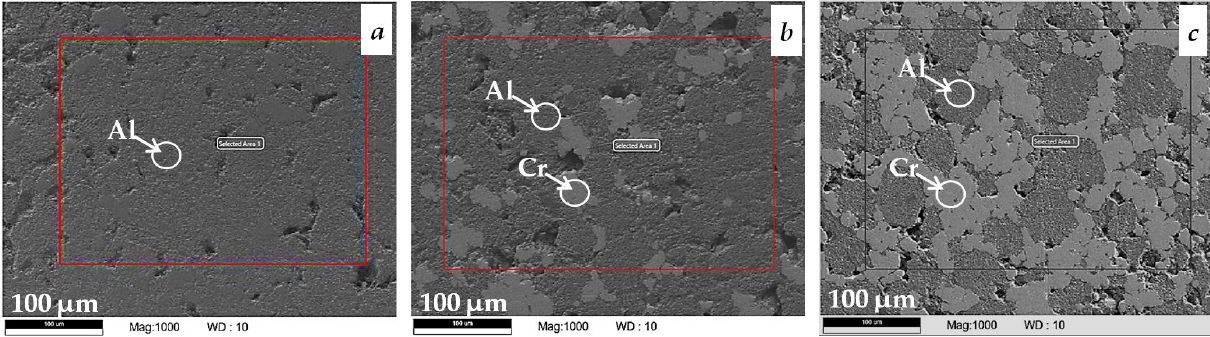
Figure 3. SEM image of composite microstructure for samples ( a ) 75A, ( b ) 50A, and ( c ) 25A. The elemental composition of the selected areas, obtained by energy-dispersive analysis, is shown in Figure 4. The increase in Cr content corresponds to its content in the initial mixture of powders used for sintering.